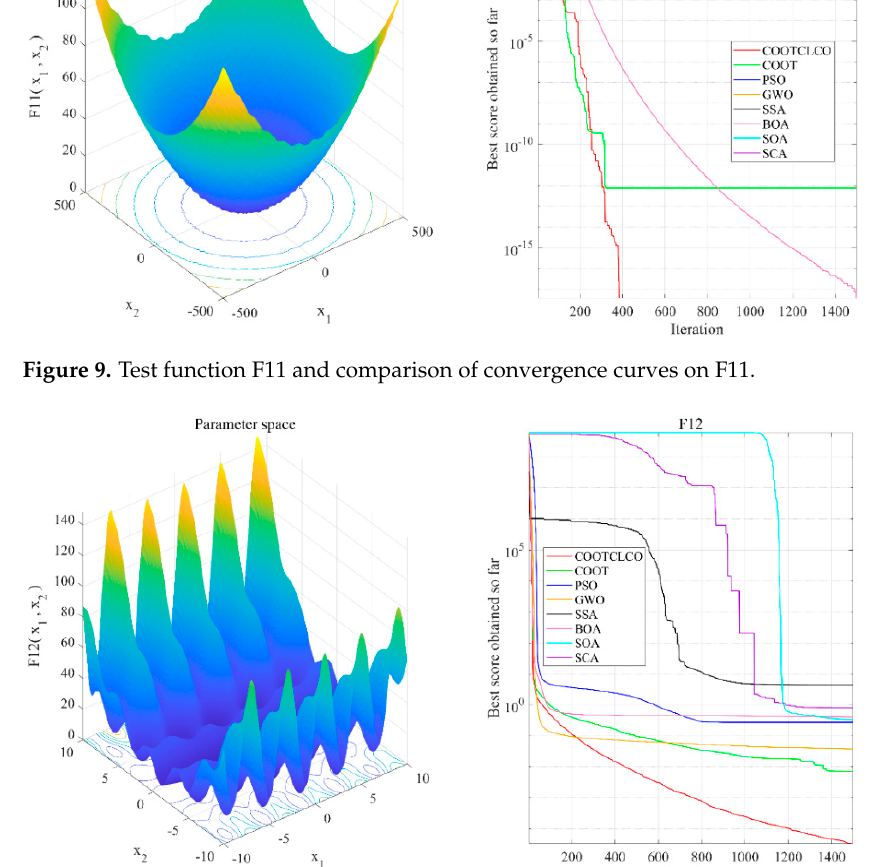
Figure 10. Test function F12 and comparison of convergence curves on F12.